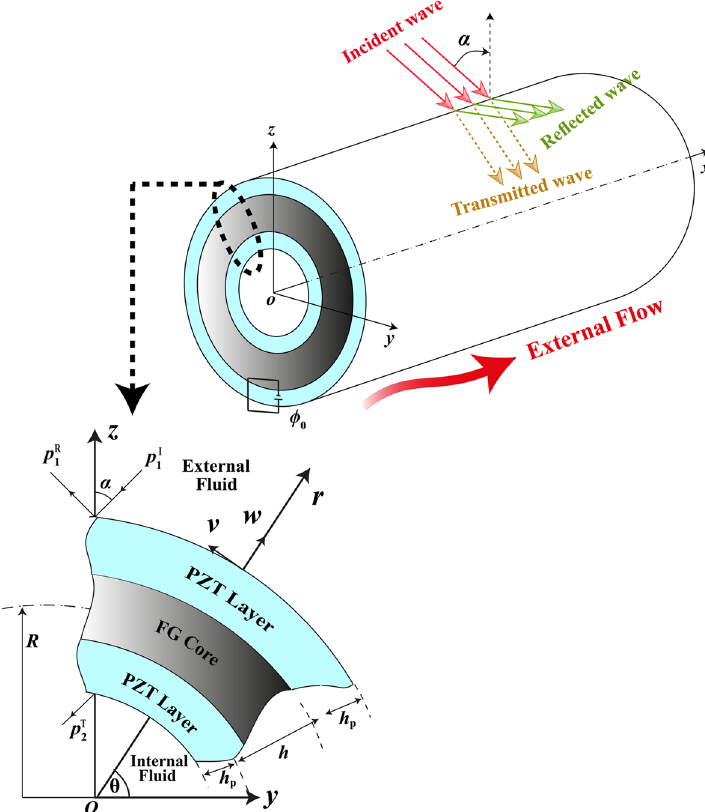
Figure 1. The schematic of a sandwich FG-PZ cylindrical nanoshell under incidence